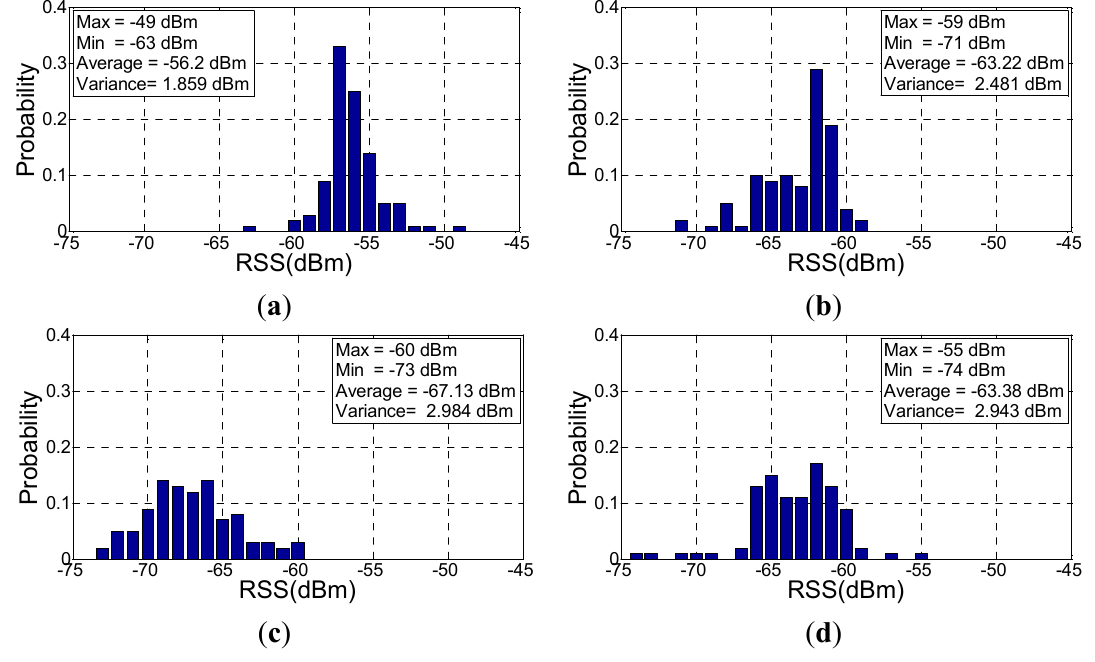
Figure 1. An example of RSS readings collection when mobile device is oriented in different directions (100 samplings for each figure). ( a